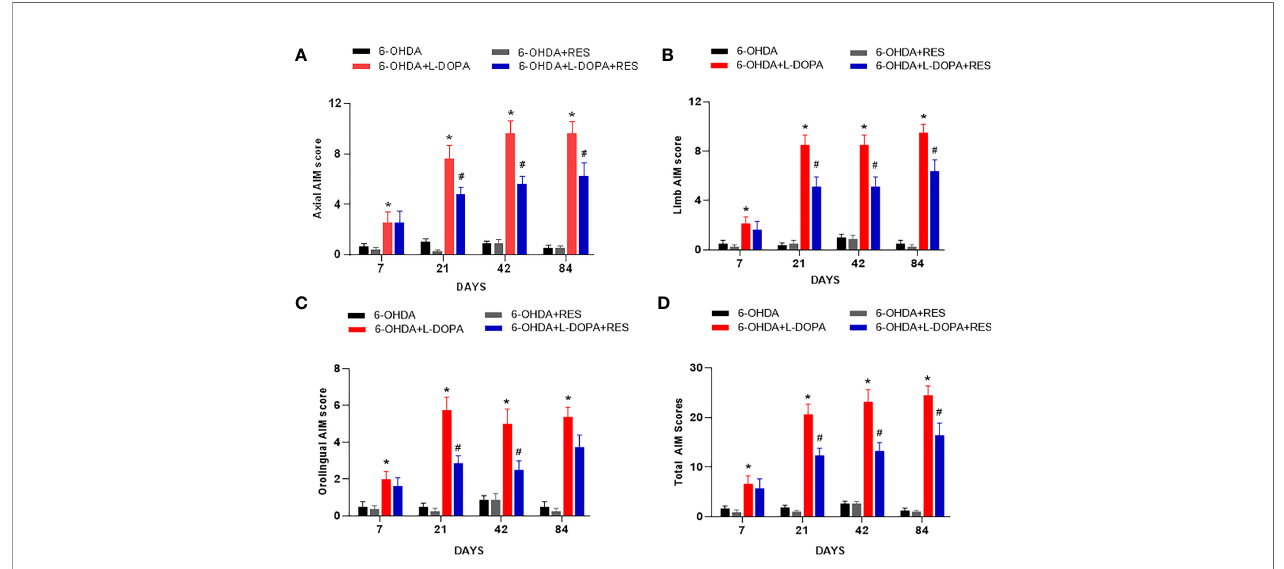
FIGURE 1 | RES alleviated dyskinesia induced by L-DOPA. L-DOPA- induced behavior changes of axial (A) , limb (B) , orafacial (C) and total AIM scores (D) were evaluated 7, 21, 42 and 84 days after L-DOPA administration, respectively. Data were expressed as mean ± SEM from 10 rats. * P < 0.05 compared with 6-OHDA group; # P < 0.05 compared with 6-OHDA+L-DOPA